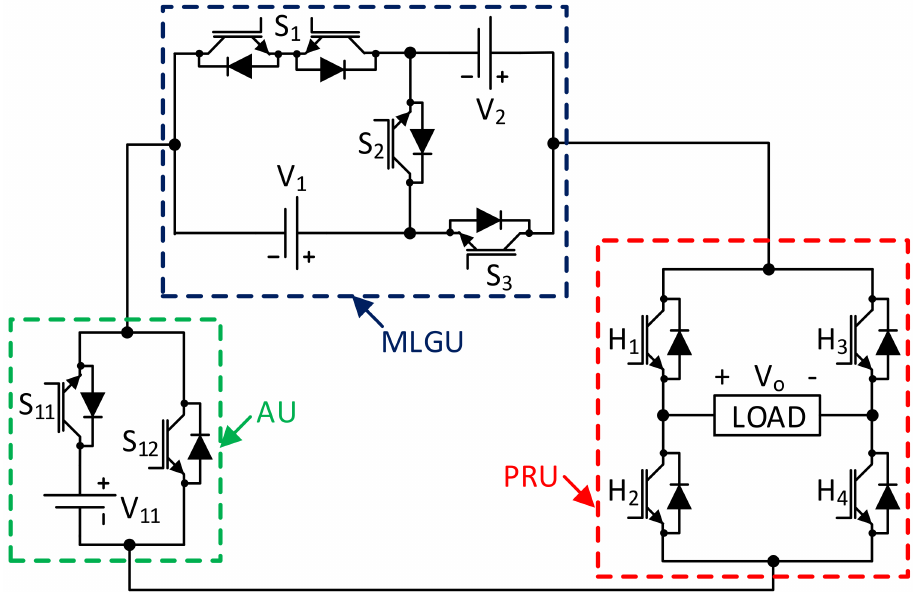
Figure 1. Proposed hybrid inverter